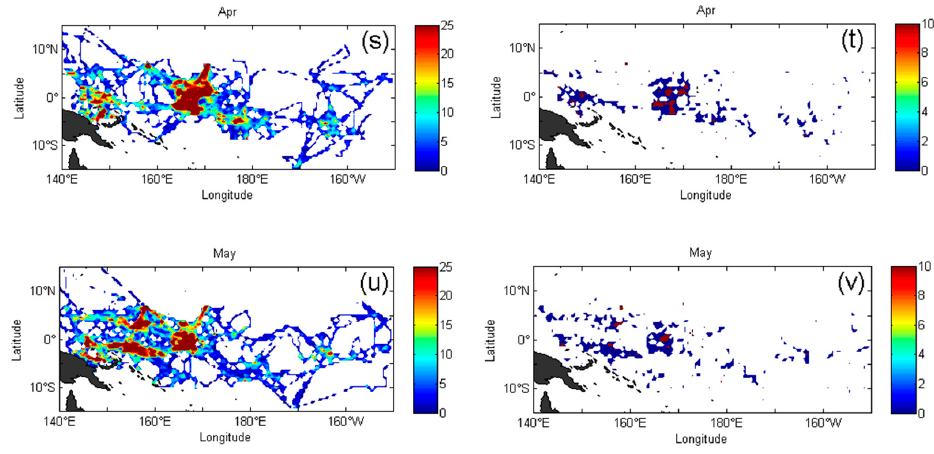
Figure 7. Spatial distribution of fishing effort intensity:( a , c , e , g , i , k , m , o , q , s , u ) high-speed transiting in search of fish during the day; ( b , d , f , h , j , l , n , p , r , t , v ) seine fishing during the day. The color bar refers to the duration of stay of vessels, and the unit is hour.